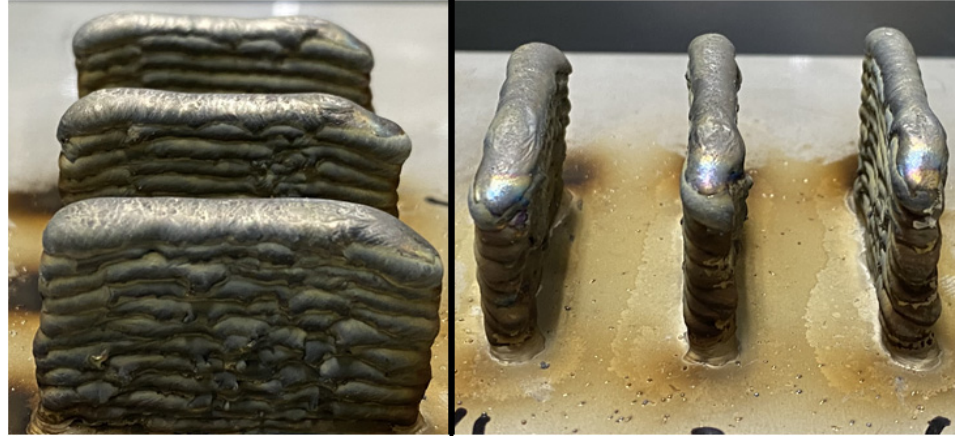
Figure 3. Example of Deposited Samples .